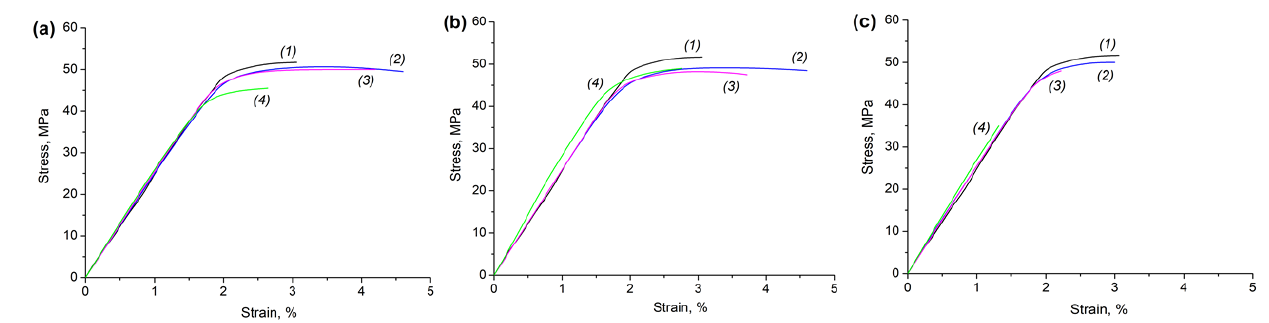
Figure 3. Stress–strain curves of composite samples with carbon nanofillers: PS + fullerenes ( a ), PS + CNT ( b ) and PS + graphene ( c ). Curves (1)–(4) correspond to filler concentrations of 0, 0.1, 0.5, and 5 wt%,